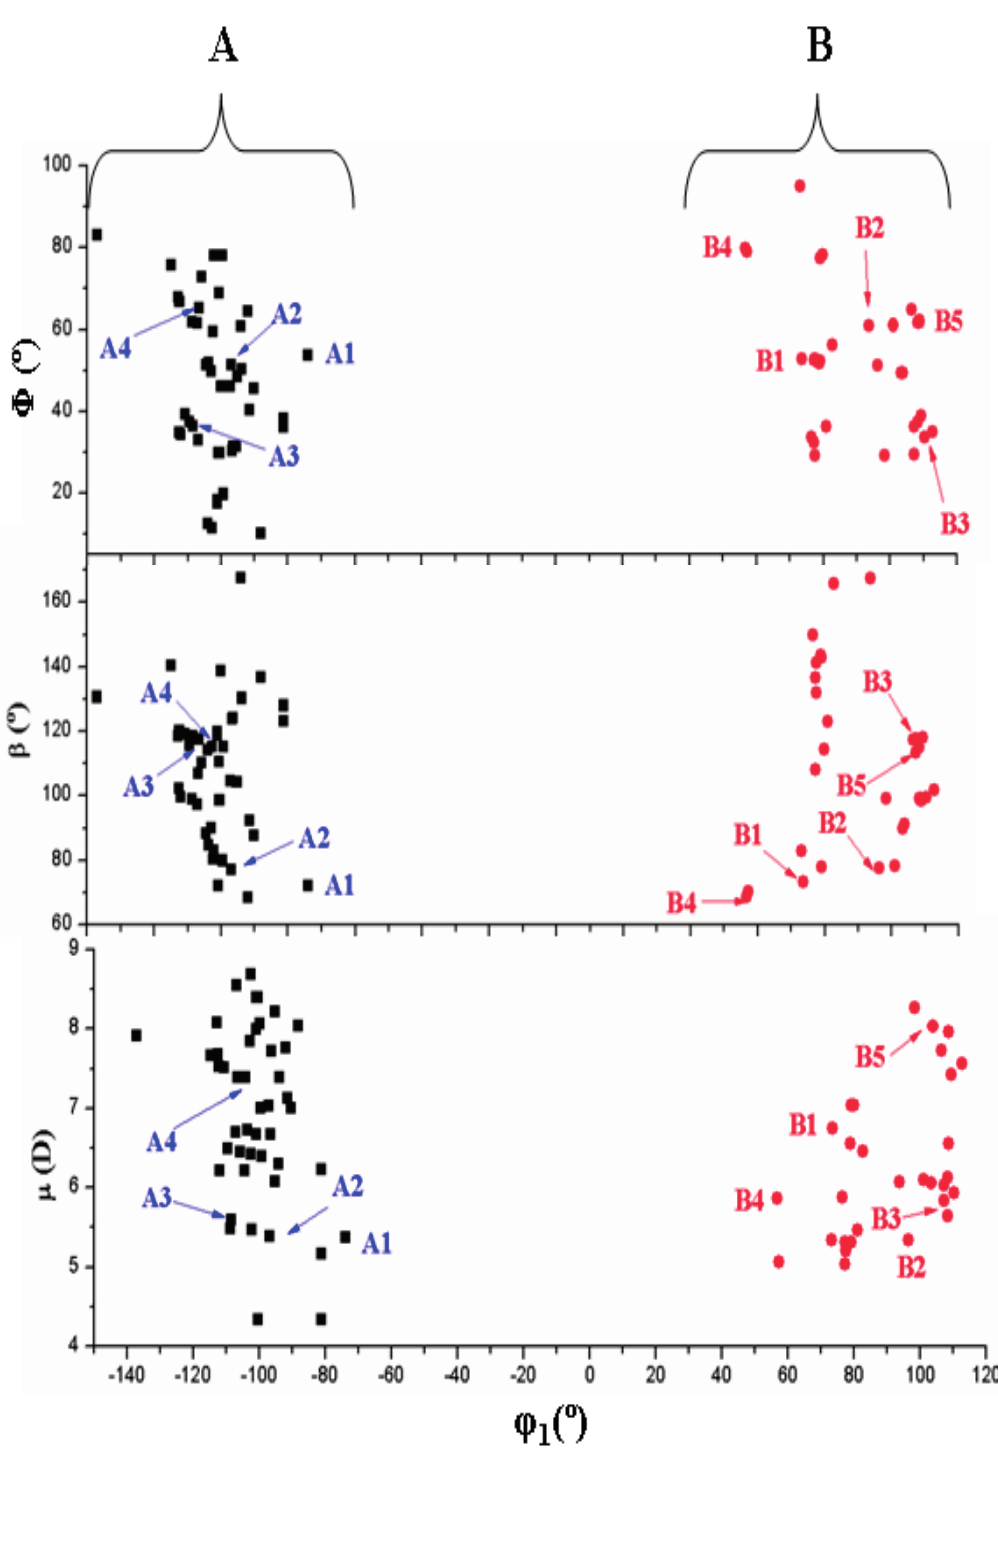
Figure 8. Distribution of the 78 optimum stable calculated conformers in tautomer N1 of acyclovir according to the values of the angles Φ and β , and the dipole moment μ versus the angle φ 1